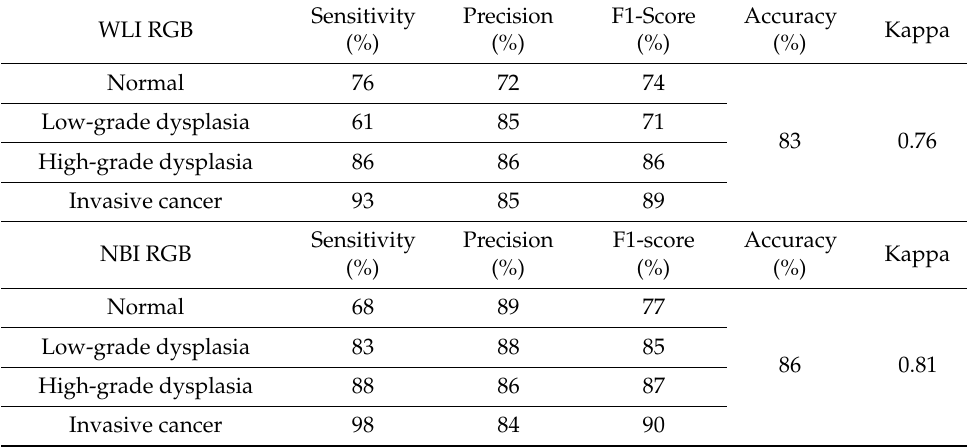
Table 1. RGB image and spectrum data test results